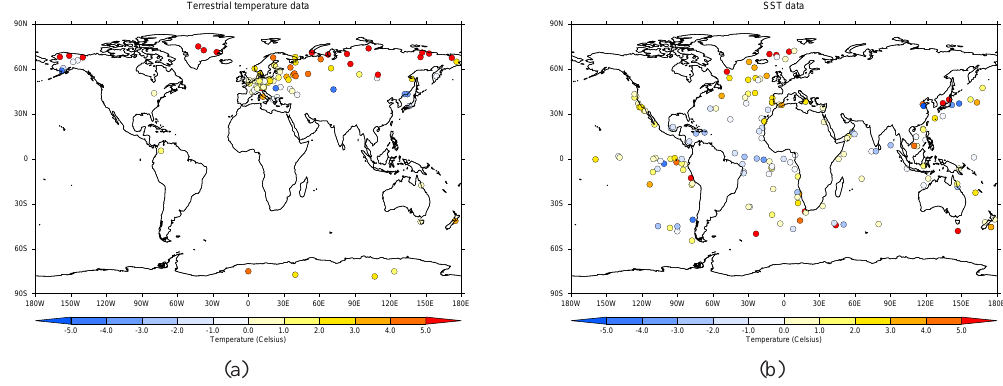
Fig. 3. Data compilation of Turney and Jones (2010), showing the LIG temperature anomaly relative to modern (1961–1990) for (a) terrestrial temperatures (100 sites) and (b) SSTs (162